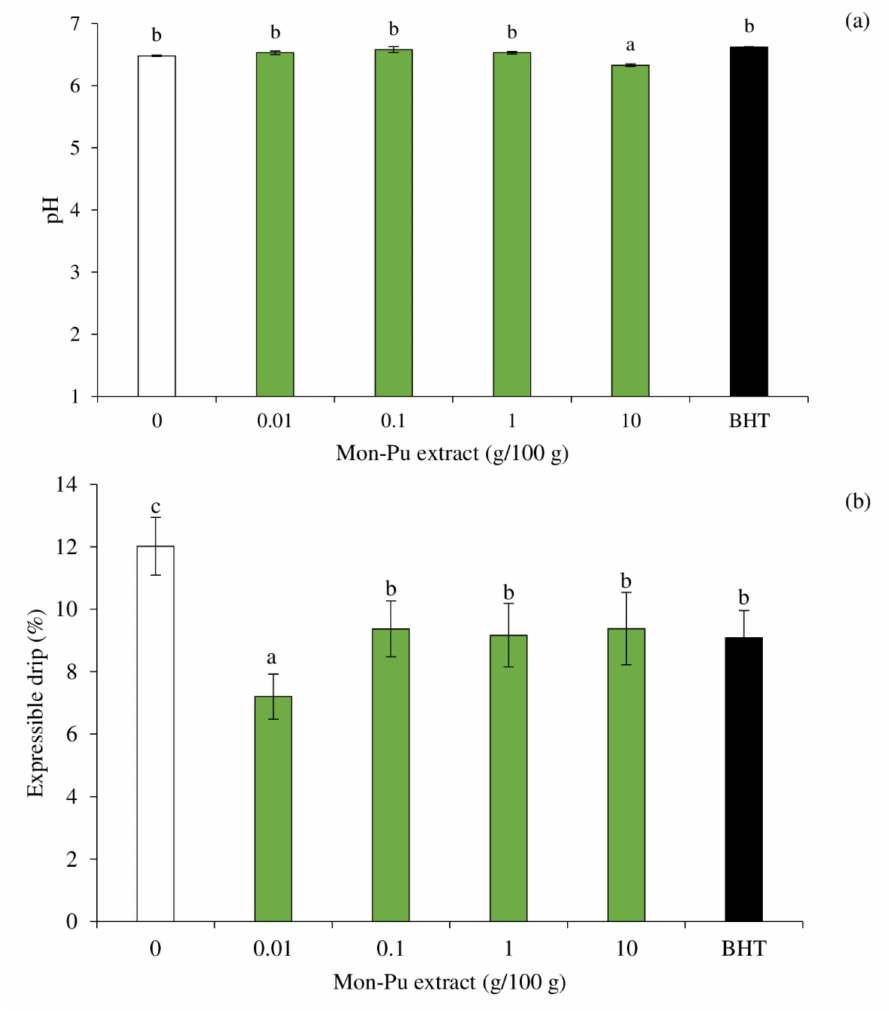
Figure 6. Effect of Mon-Pu leaf extract (MPE) on pH ( a ) and expressible drip ( b ) of a cooked sausage model system (SMS). Butylated hydroxyl toluene (BHT) at 0.003% was used to compare. Bars represent the standard deviations from triplicate determinations. Different letters indicate the significant differences ( p <